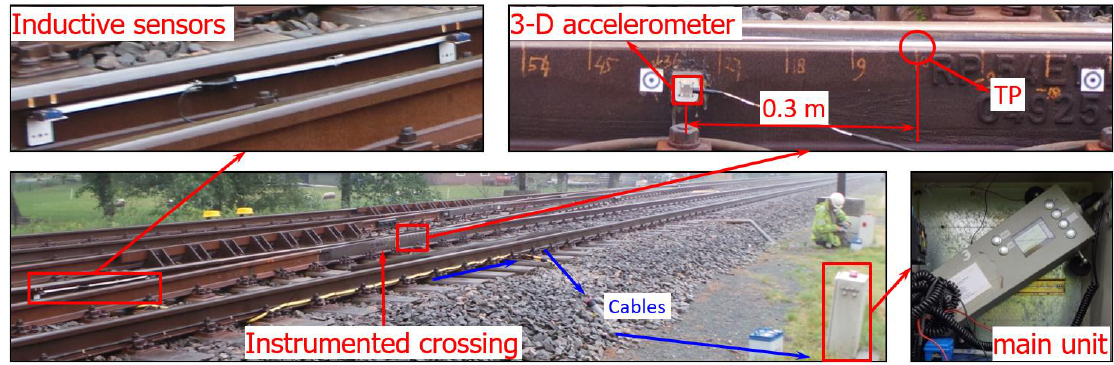
Figure 4. Overview of the crossing instrumentation. TP: Theoretical point.